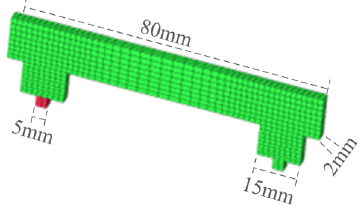
Figure 6. GIS model plum touch finger.